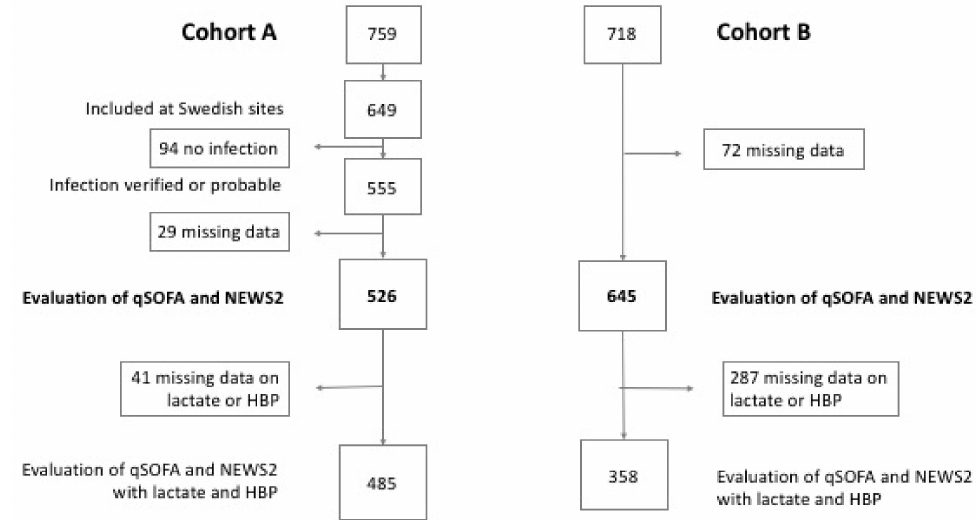
Figure 1. Flow chart. Cohort A, patients with suspected infection and one of systemic inflammatory response syndrome (SIRS) criteria, or self-reported fever or chills. Cohort B, patients with one of the following parameters: respiratory rate > 25, heart rate > 120, altered mental awareness, SBP < 100 mmHg, SaO 2 < 90%, or < 93% if ongoing treatment with oxygen. qSOFA (Quick Sequential